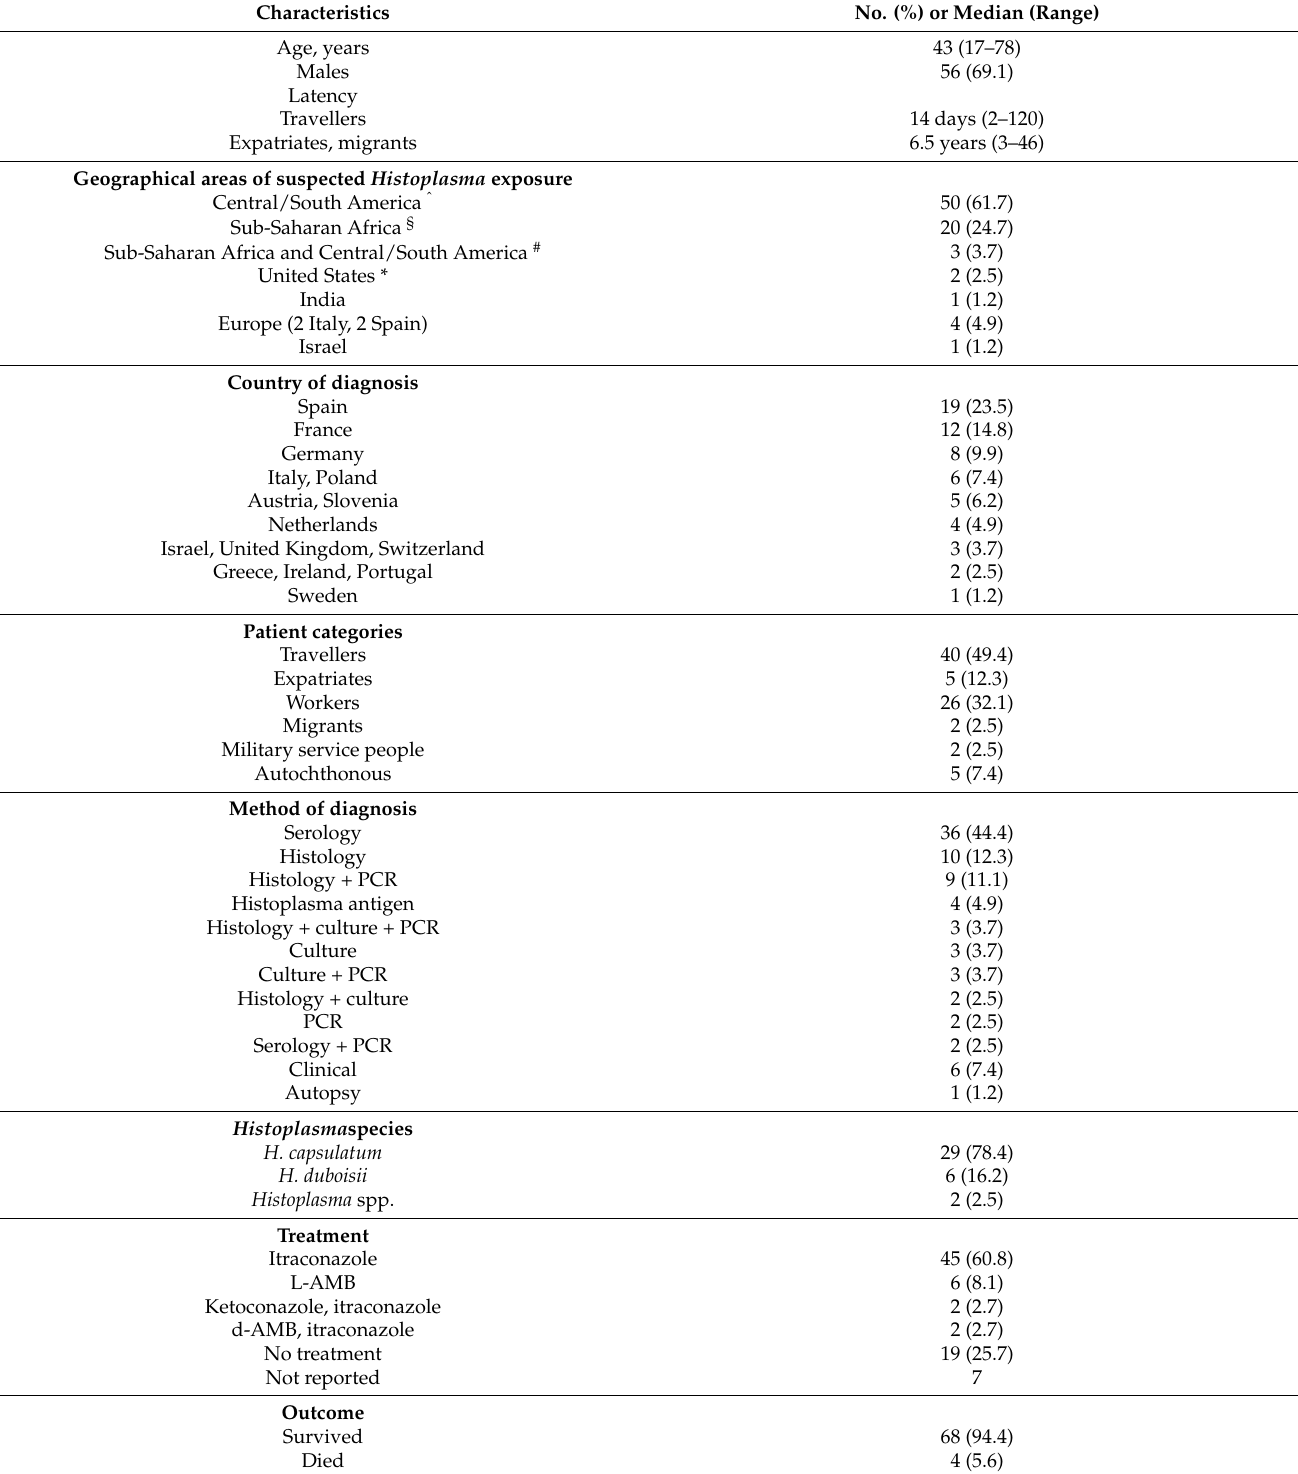
Table 6. Characteristics of 81 cases of histoplasmosis among immunocompetent subjects diagnosed in Europe and Israel.